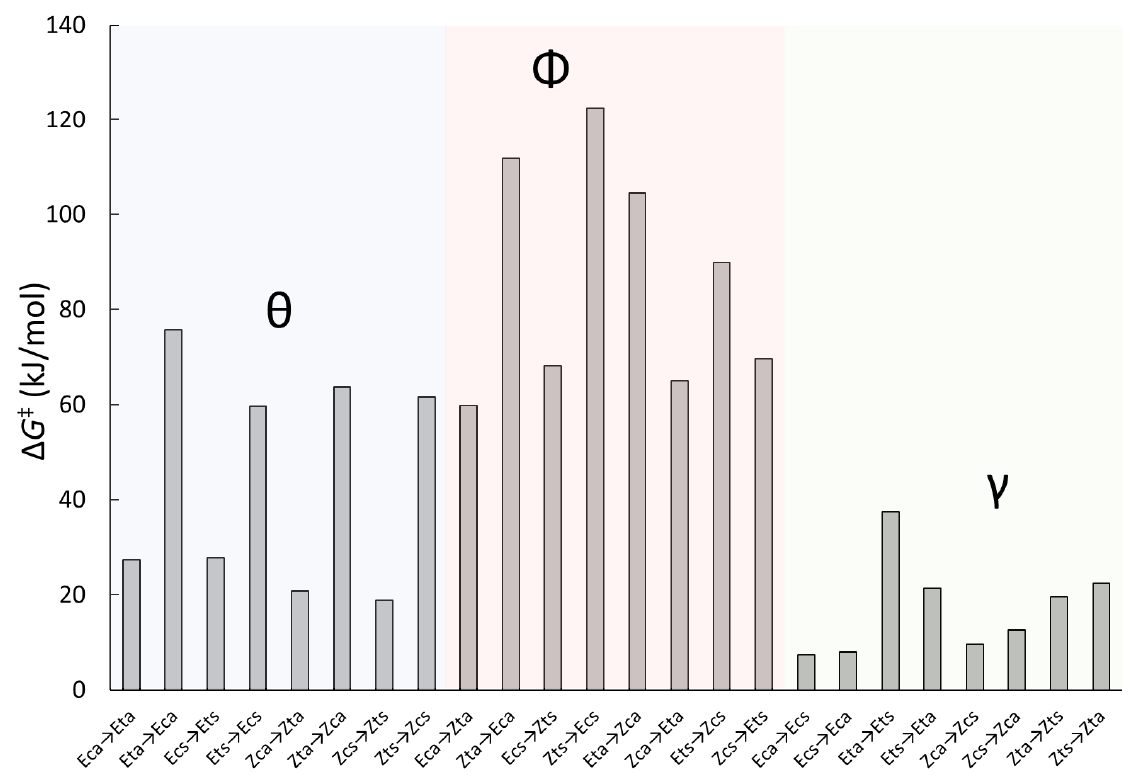
Figure 14. Activation barriers, Δ G ‡ , at 298 K of the isomerization processes of 1 calculated at ω B97M-D4/cc-pVTZ level of theory. The barriers are grouped as to the isomerization type. Selected TS structures are shown in Figure 15 and selected molecular geometric parameters of the TS structures of 1 are collected in Table 9.